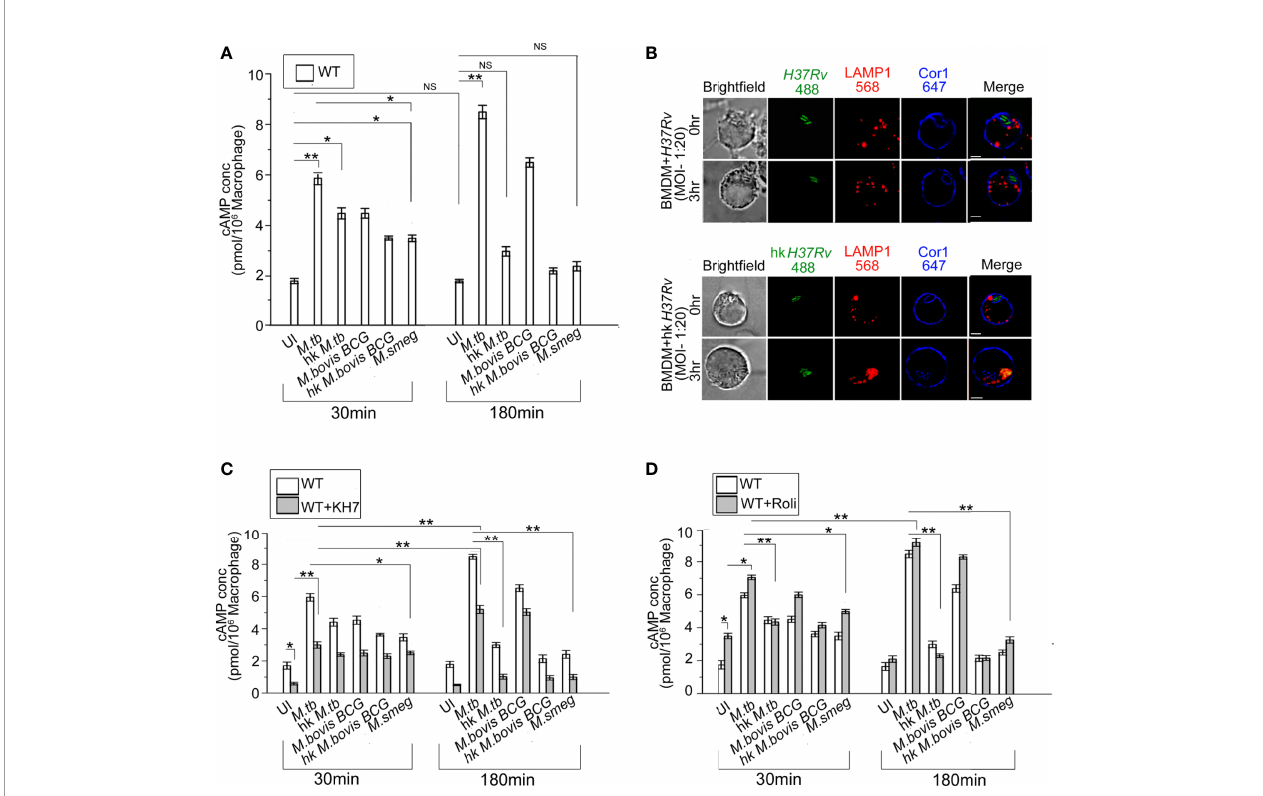
FIGURE 1 | (A) Intracellular cAMP concentration in uninfected and live M. tb , M. bovis BCG , M. smeg , heat-killed M. tb , and heat-killed M. bovis BCG infected BMDM after the indicated time points using competitive ELISA. (B) Immuno fl uorescence analysis of mycobacteria-infected macrophages. WT-BMDM infected with live M. tb or hk M. tb for indicated time points were stained for mycobacteria (green), lysosomes (LAMP1 in red), and Cor1 (blue). In the case of live M. tb- infected macrophages Cor1, recruited around phagosomes at 0-h time point was retained even after 3 h of infection, while for hk M. tb -infected macrophages Cor1 was not retained after 3 h of infection (scale:10 m m). (C, D) Competitive ELISA-based measurement of intracellular cAMP concentration in uninfected or live M. tb , M. bovis BCG , M. smeg , heat-killed M. tb , and heat-killed M. bovis BCG infected BMDM for the indicated time points without and after pretreatment with (C)